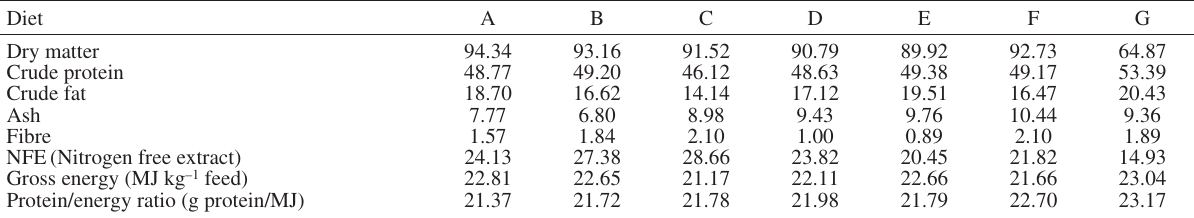
Table 2. – Proximate composition of the tested diets expressed as a percentage of dry matter.